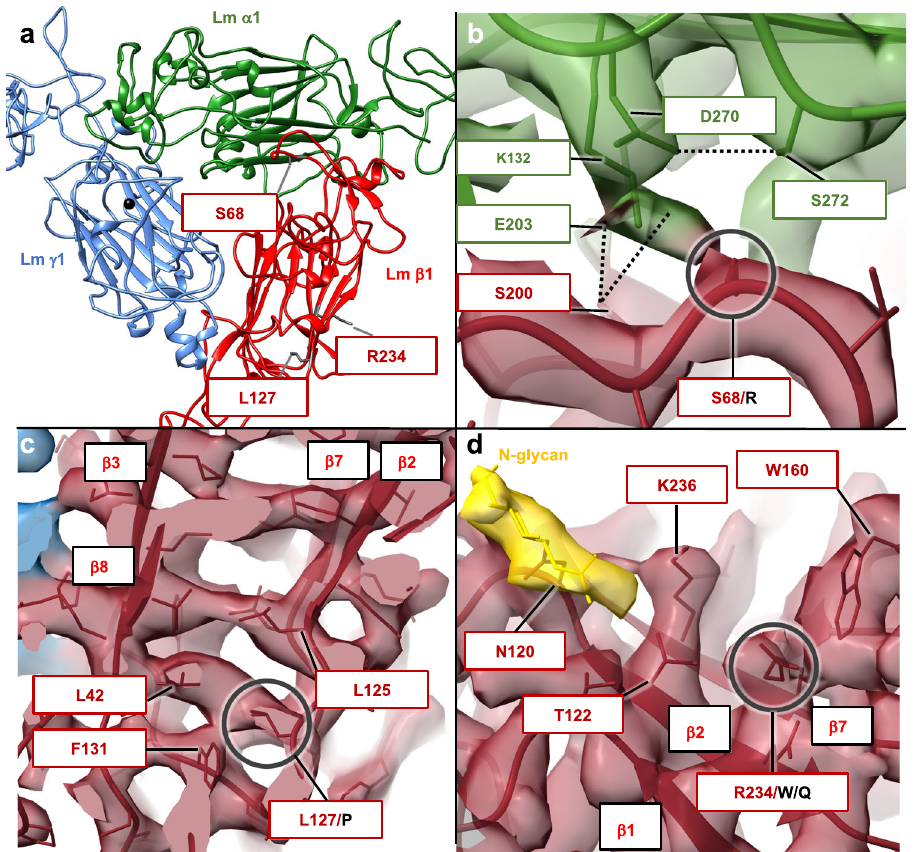
Fig. 3 | Molecular basis of Pierson syndrome. a Mutations causing Pierson syn- drome are located in β 1 and indicated by red boxes in the fi gure. Lm α 1, β 1 and γ 1 are shown in green, red and blue, respectively. A calcium ion is shown as a black sphere. b S68Rdestabilizesthe β 1- α 1interfacebydisruptinganetworkofhydrogen bonds indicated in the fi gure as black dotted lines. c L127P destabilizes the